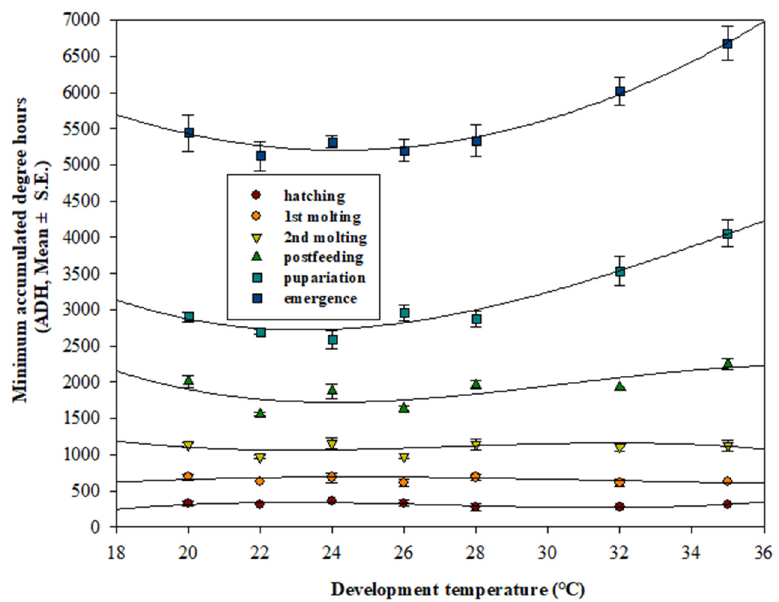
Figure 4. Minimum accumulated degree hours (ADH) model for Lucilia sericata developed by accumulated minimum development hours at each developmental stage, at seven temperature re-